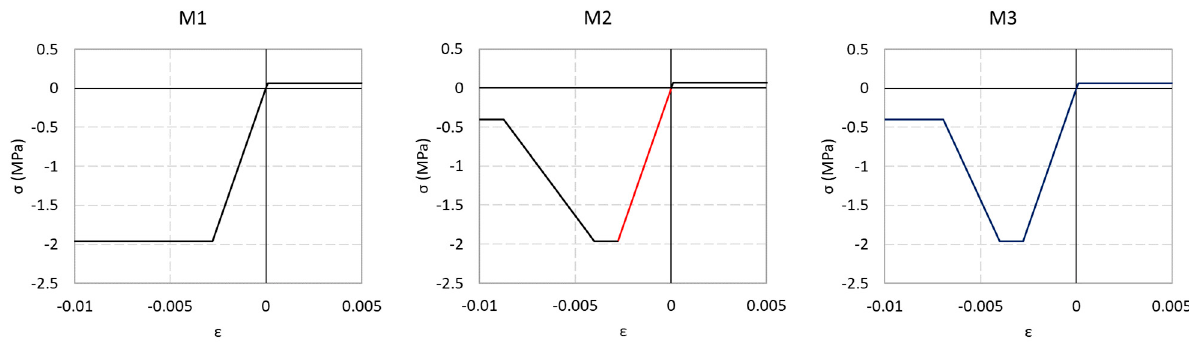
Figure 5. Stress–strain relationship of the masonry, M1—Perfectly elasto-plastic, M2—Idealized brittle material with softening, M3—Idealized brittle material with sudden